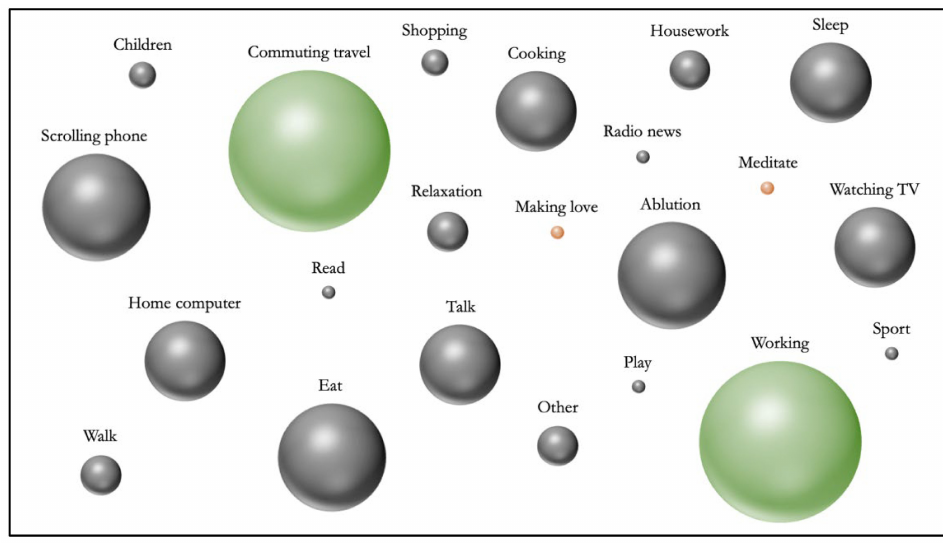
Figure 2. Frequency of different activity during MW episodes. Table 4. Mind wandering’s probes: Descriptive statistics of ongoing activities during thought